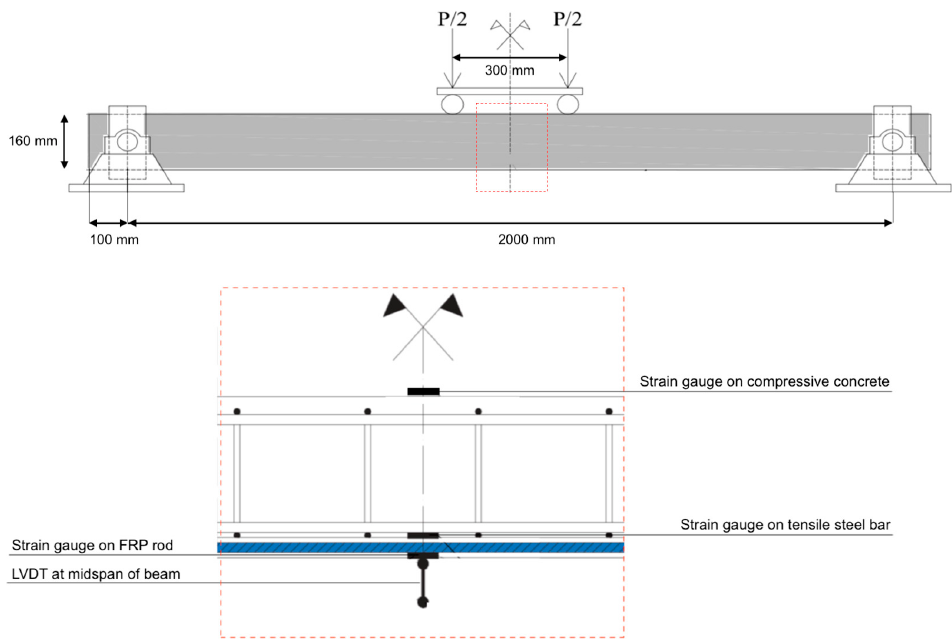
Figure 3. Setup of bending test.